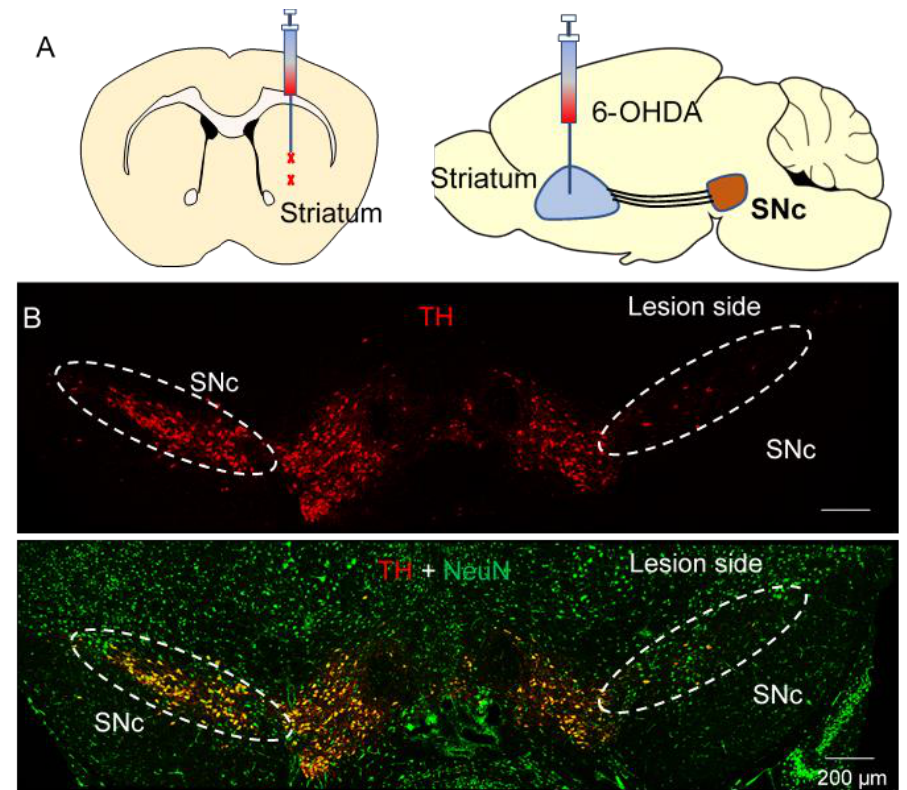
Figure 1. 6-OHDA induced selective degeneration of SNc dopamine neurons. ( A ) Diagram showing the two targeted 6-OHDA injection sites in the striatum, where it is taken up by SNc axonal terminals. ( B ) Immunohistochemistry for TH in the SNc and neighboring VTA of mice that received unilateral injections of 6-OHDA (top). Immunohistochemistry for TH overlaid with NeuN shows the selectivity of 6-OHDA for dopamine neurons (bottom), n = 3 mice.